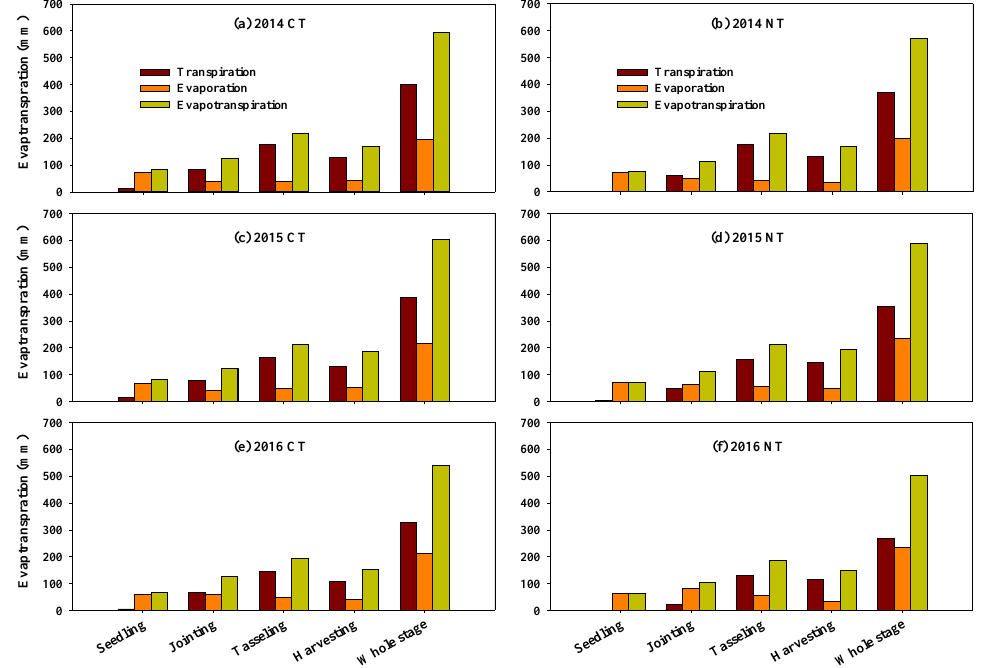
Figure 7. Simulated change in evapotranspiration at different stages during 2014‒2016.